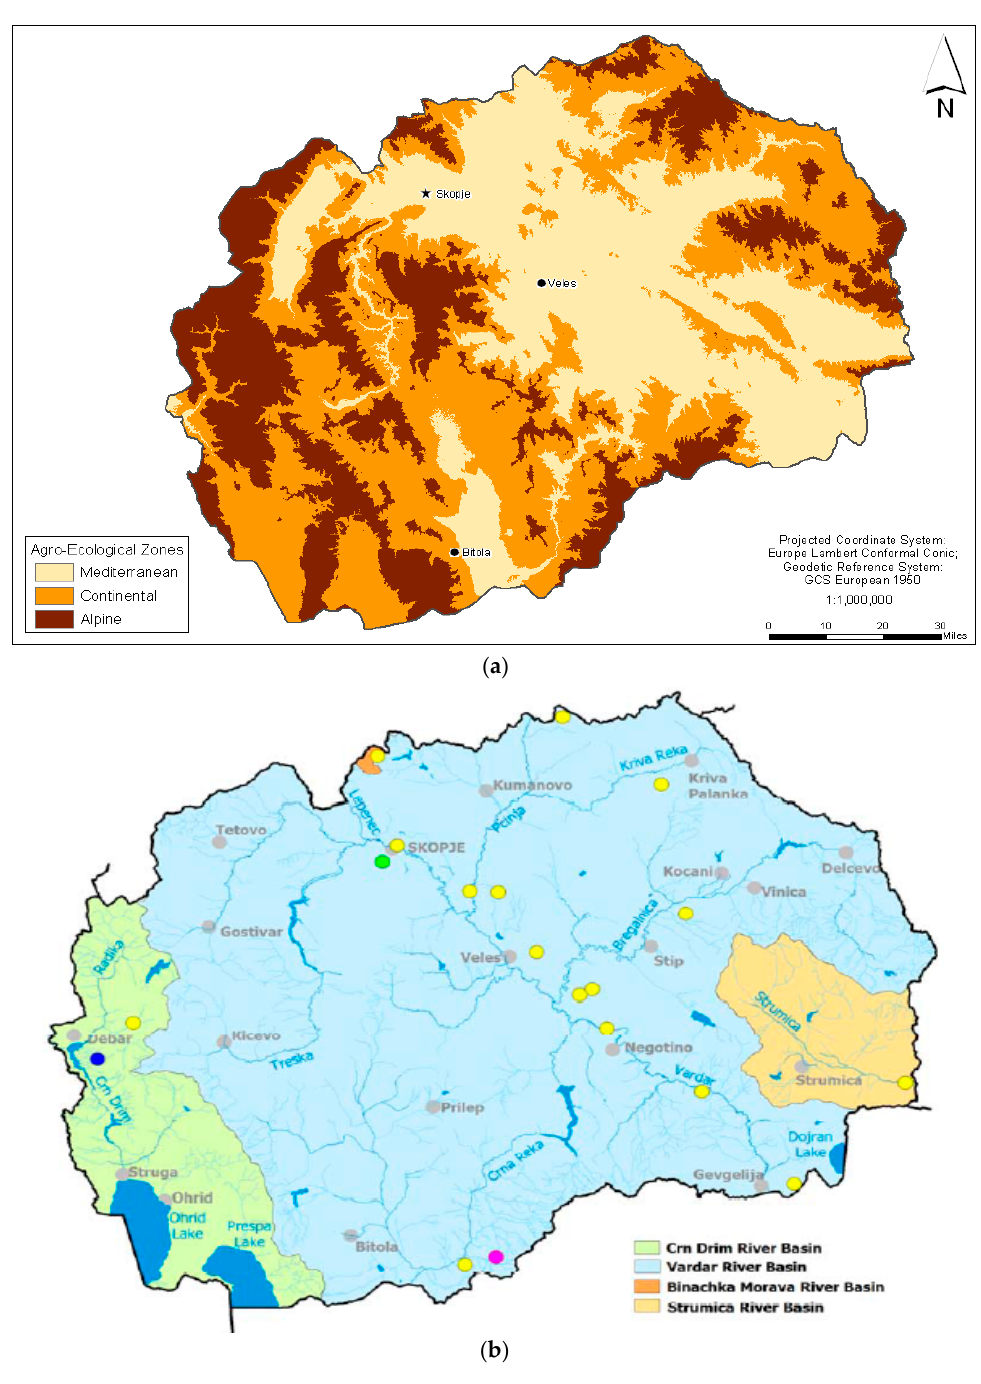
Figure A1. ( a ) Three agro-ecological zones (AEZ) (Source: [30]) and ( b ) four river basin zones (Source: [45]) in the Republic of Macedonia.